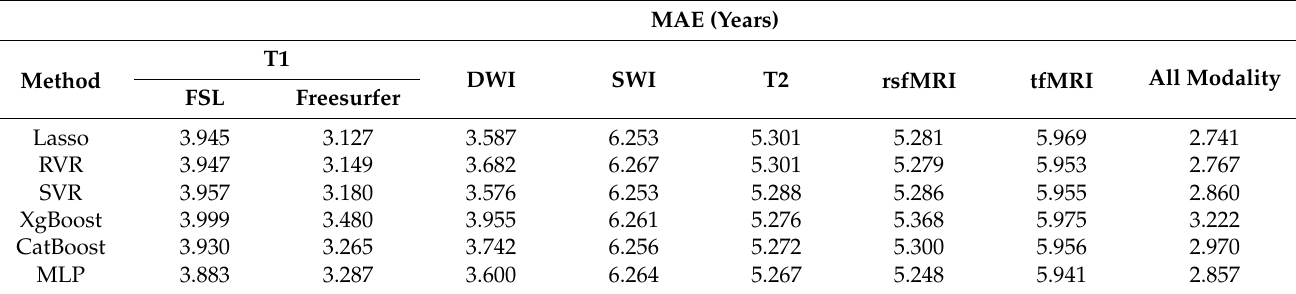
Table 4. Prediction performance of six ML